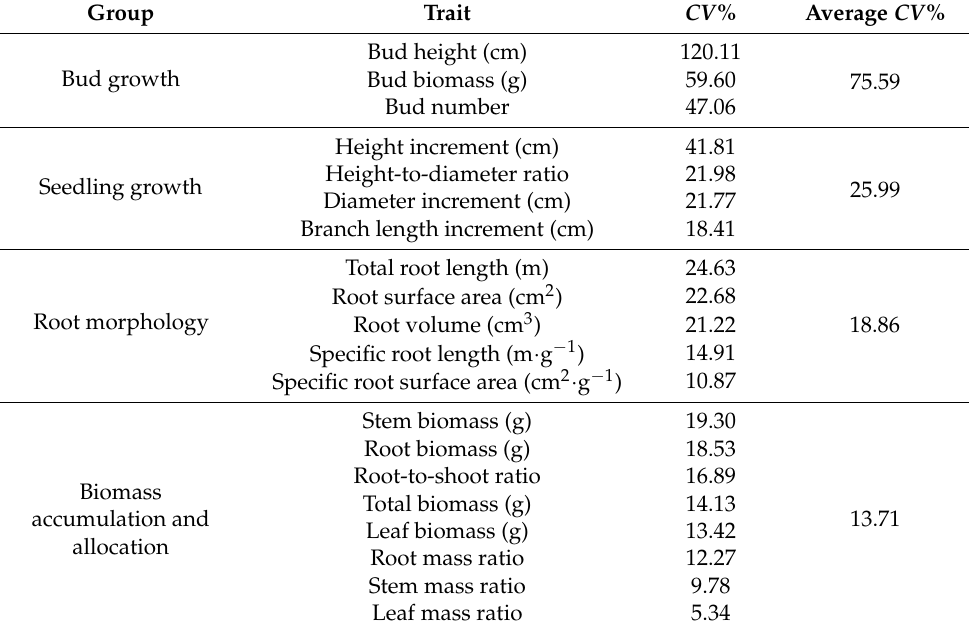
Table 3. Coefficient of variation ( CV %) for each trait ranked from highest to lowest.